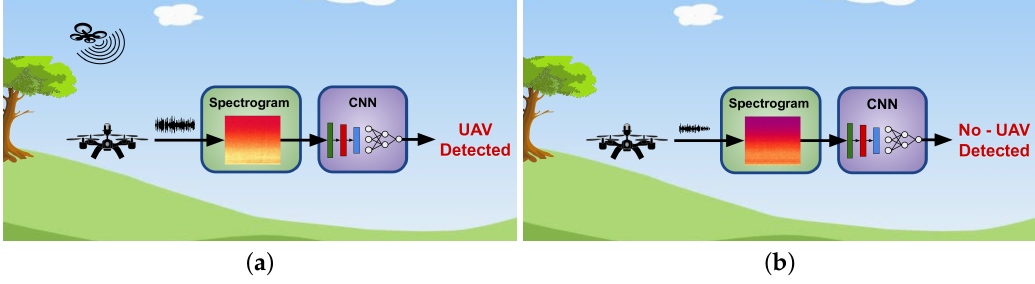
Figure 7. Illustrative example of convolutional neural network (CNN)-based auditory perception for the air-to-air category. In this example, the objective is to carry out UAV detection, that is, whether a UAV is in the scene or not. The audio signal acquisition is performed by another UAV. The audio signal is converted into a spectrogram image, which is passed to a pre-trained CNN model. This network has been trained to output two classes: ( a ) UAV Detected; ( b ) No UAV